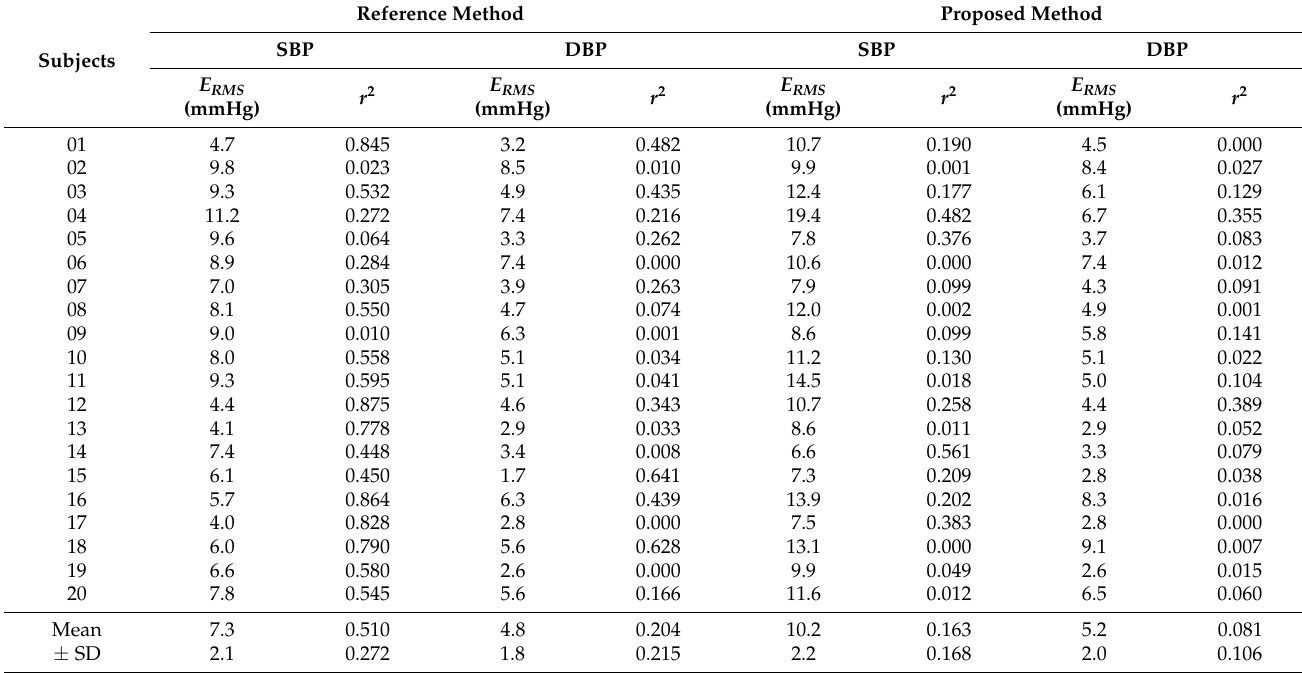
Table 2. Results of estimated SBP and DBP with Equation (3) for the reference and proposed methods.